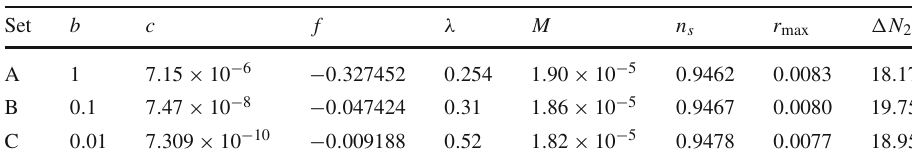
Fig. 12 The PBH-to-DM fraction for the parameter sets A (solid black curve), B (dashed blue curve) and C (magenta curve) from Table 7, with ˆ f ≈ 1 in all cases. The tot background of observational constraints is taken from Refs. [12,13]: from evaporation (red), lensing (blue), gravitational waves (gray), various dynamical effects (green), accretion